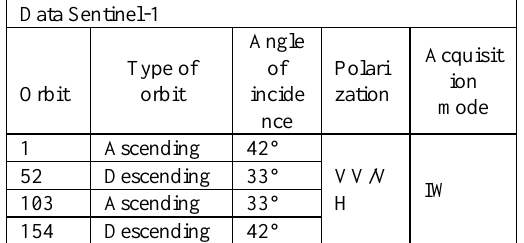
Table 1: Sentinel-1 images available